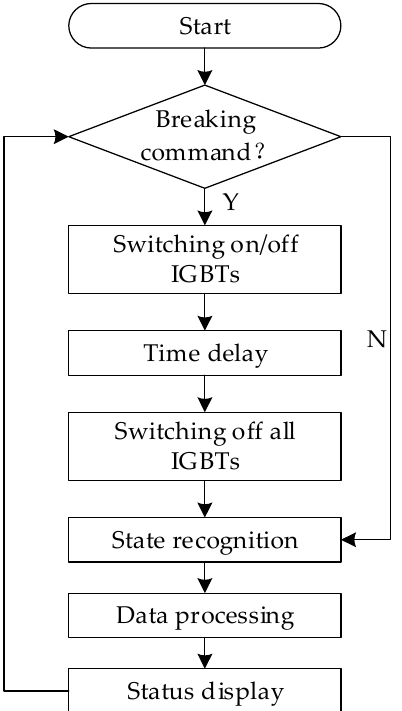
Figure 9. Hardware block diagram.